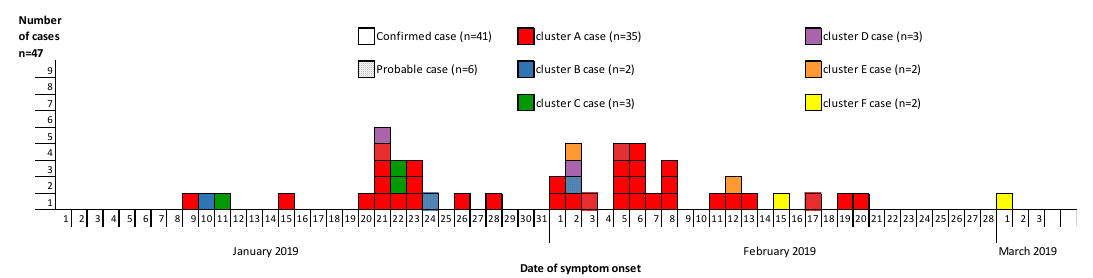
Figure 1. Measles (confirmed and probable) cases according to date of symptom onset, Austria, January–March 2019 (n = 47).